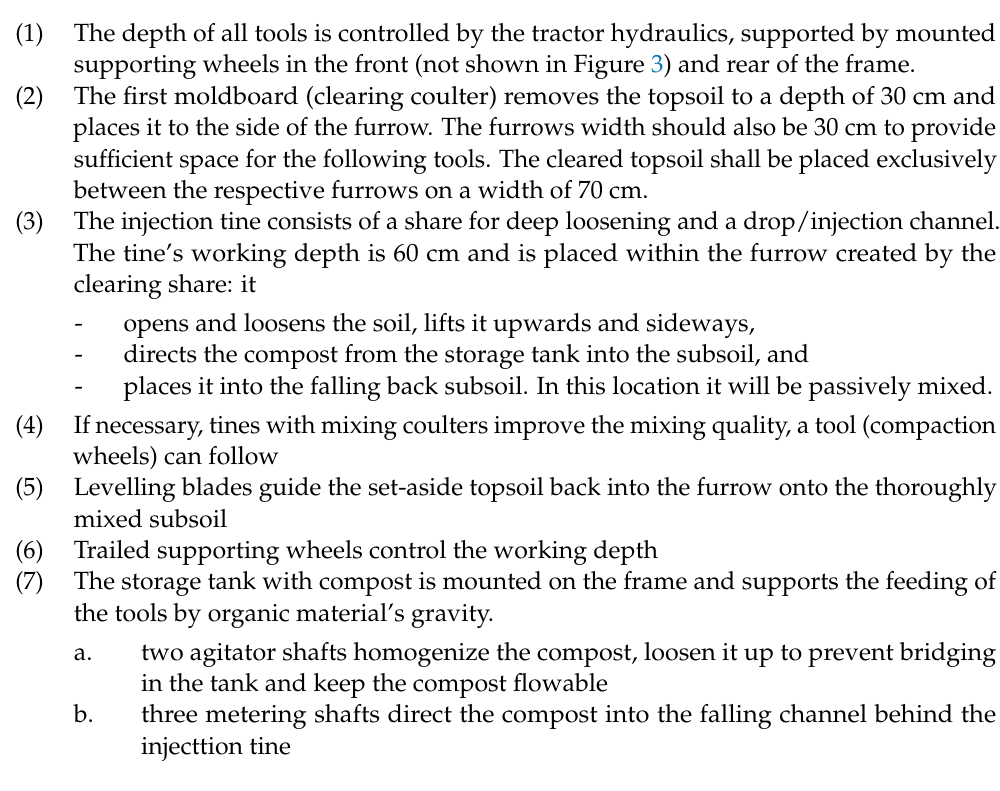
Figure 3. Scheme of the technology concept of a single-phase machine to be developed.